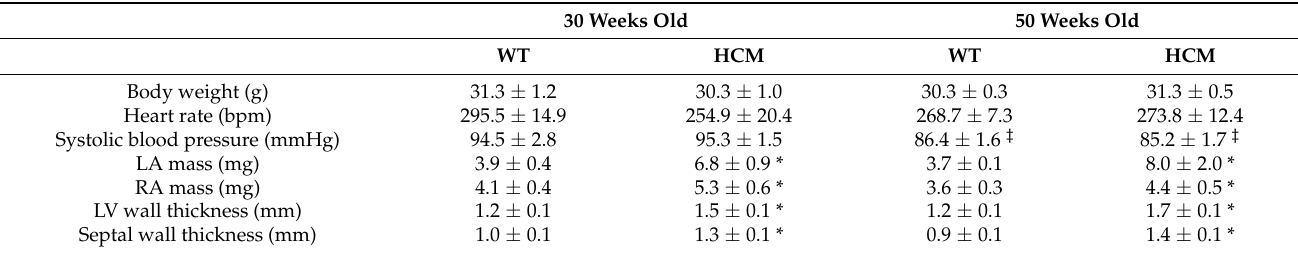
Table 1. Animal characteristics and heart chamber